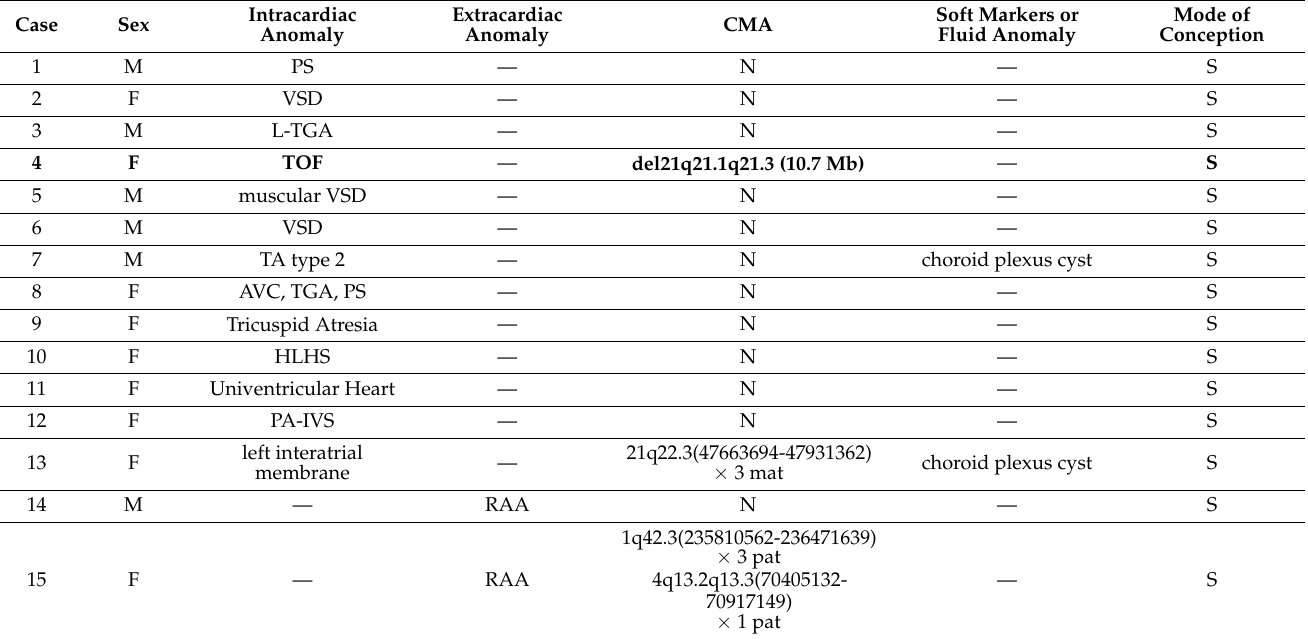
Table 3. Retrospective cohort of fetuses with isolated